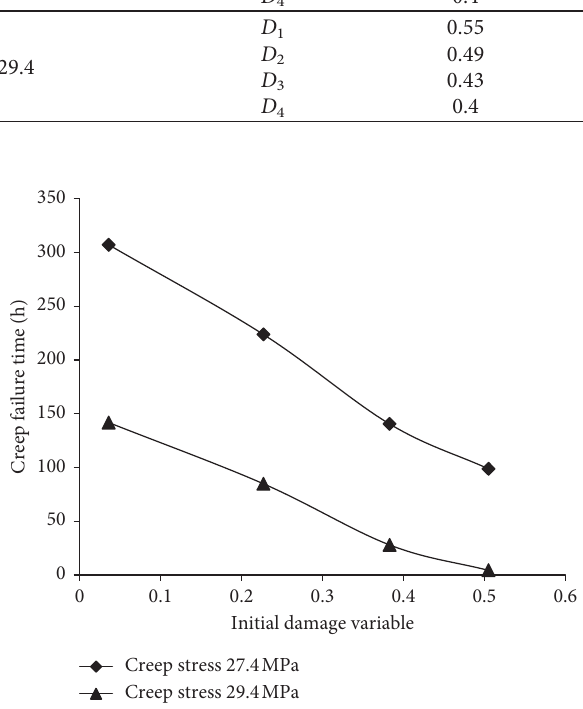
Figure 13: Relationship between the initial damage of rock and creep failure